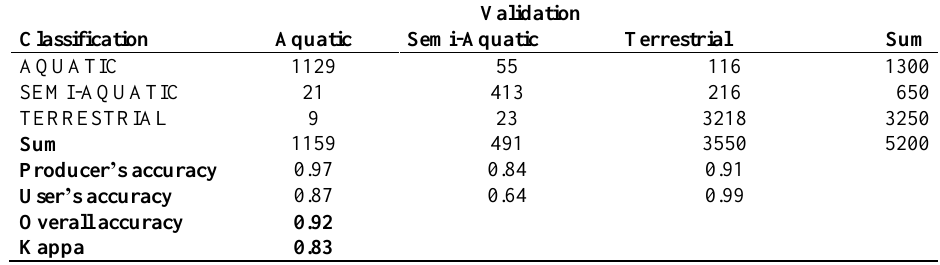
Table 6. Confusion matrix for fine-scale classification of the 10 images (Step 8), considering the hydrological groups (aquatic, semi-aquatic, and terrestrial) of the validation